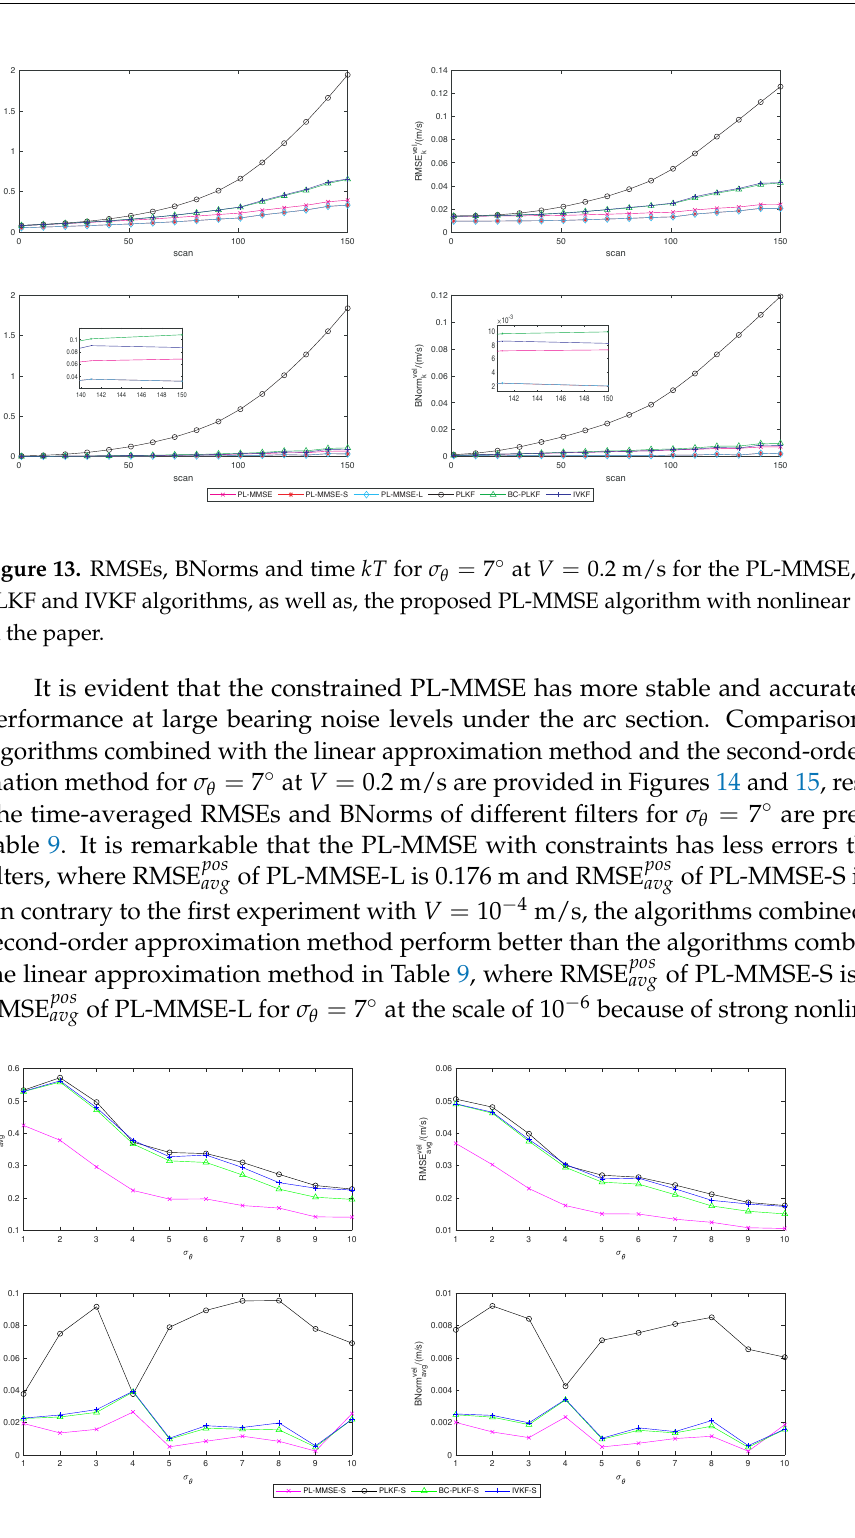
Figure 14. Time-averaged RMSEs, BNorms and bearing noise standard deviation at V = 0.2 m/s for the four algorithms combined with the linear approximation